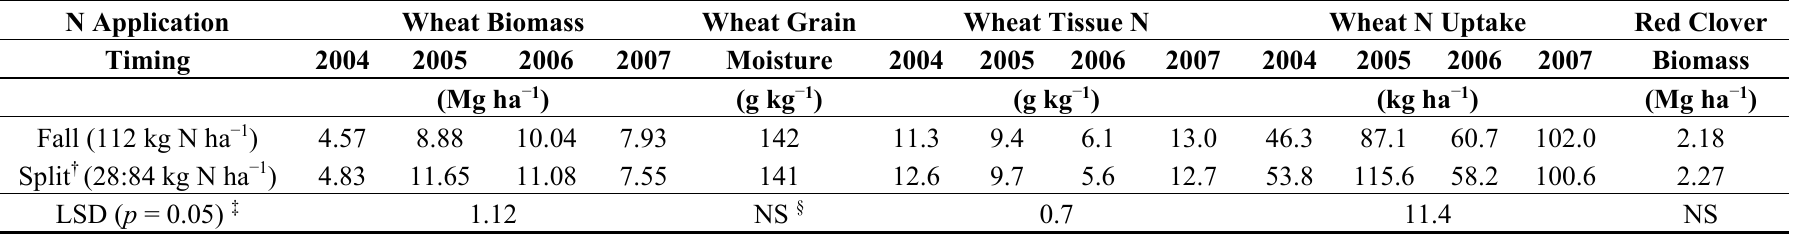
Table 5. Effect of nitrogen application timing on wheat biomass, grain moisture, wheat tissue N, wheat N uptake, and red clover biomass dry matter; data were averaged over N sources (AN, ammonium nitrate; PCU, polymer-coated urea; UAN, urea ammonium nitrate; urea; and urea plus NBPT and years in the absence of a significant